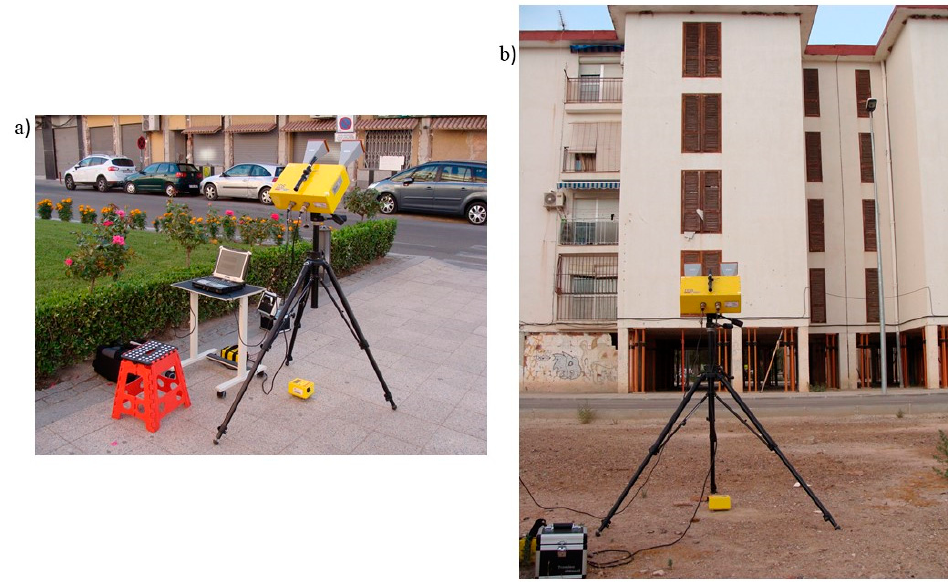
Figure 9. RAR. ( a ) RAR device and ( b ) RAR device and building. Photos: Dr. Ramón Gonzalez-Drigo. Source: [6]. Figure 2, page 18.